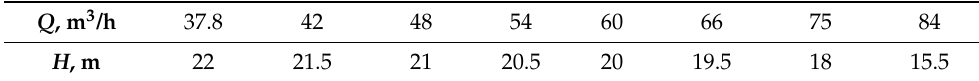
Table 1. Pump H-Q characteristic.